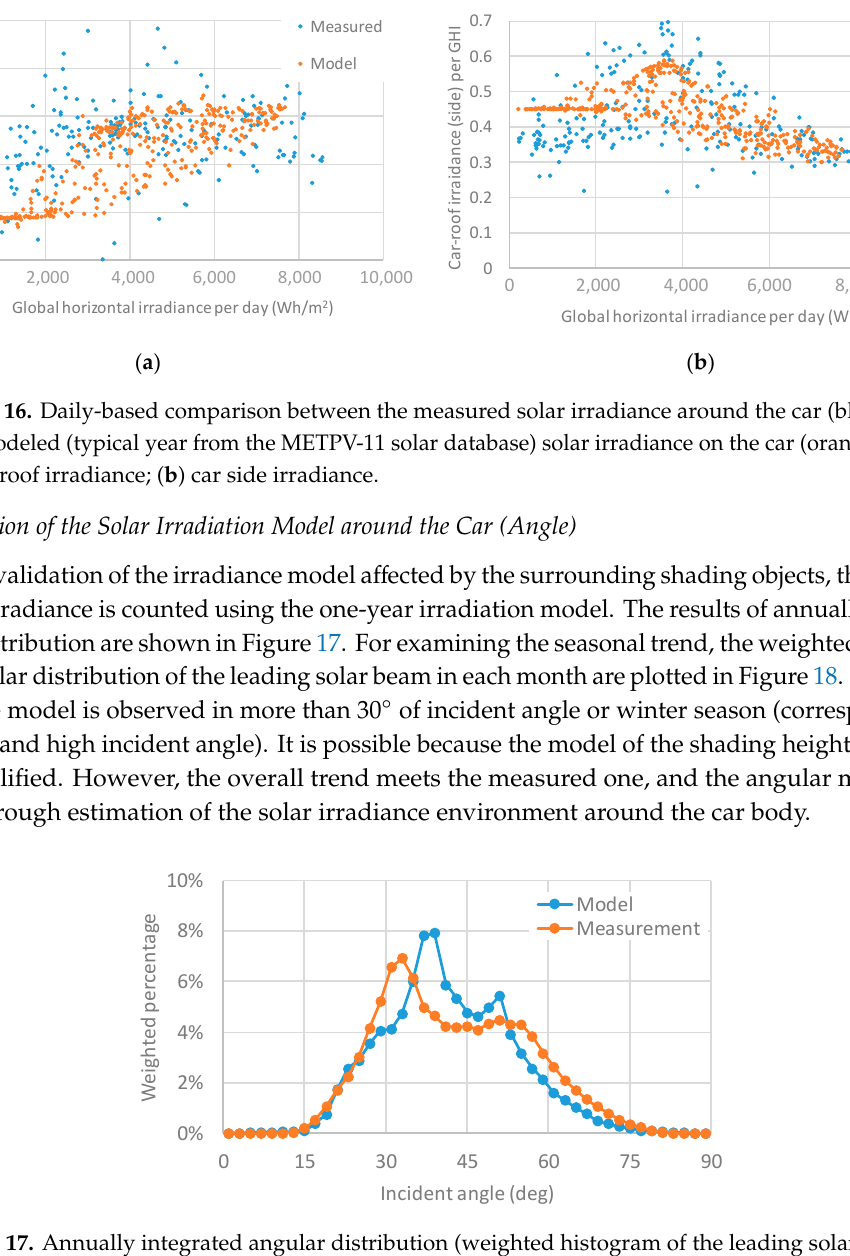
17 of 27 Table 2. Comparison of model and measurement (relative to GHI) by one-year monitoring of a passenger’s car. Measured Model by Rough Physical Measurement Modeled by Parameter Fit (Average Height of Shading Objects and Reflectance of the Road) 1 Car roof 0.435 1 The degree of freedom and the number of fit parameters are the same (= 3). The validation is also done by a one-month integration (seasonal fluctuation). The model met the modeled values in every month (Figure 15). The trend of the residual errors could be explained by the difference in climate from the regular year (for example, cloudy in summer). ( a ) ( b ) Figure 15. Monthly-based comparison between the measured solar irradiance around the car (bar- chart) and modeled (typical year from the METPV-11 solar database, namely, MEteorological Test data for PhotoVoltaic system) solar irradiance on the car (line-chart): ( a ) car roof irradiance; ( b ) car